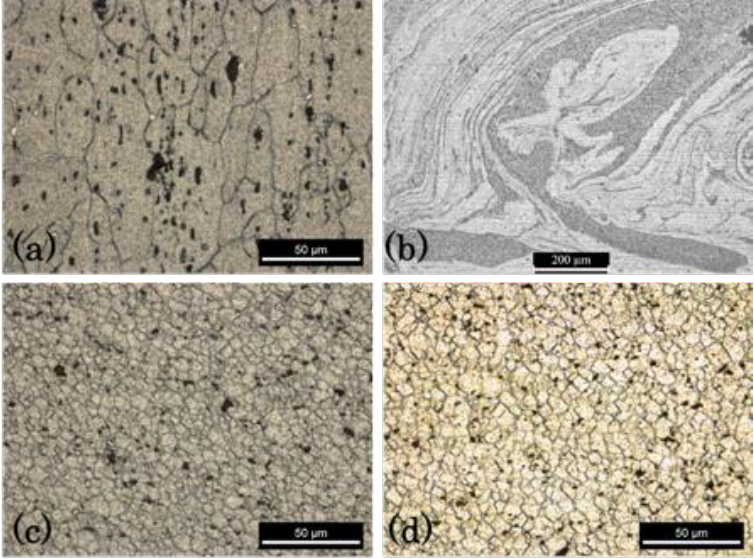
Figure 8. Microstructure of the: ( a ) base material AA 6082, ( b ) nugget of the 562-120 series, ( c ) nugget of the 562-30 series, and ( d ) nugget of the 265-30 series.